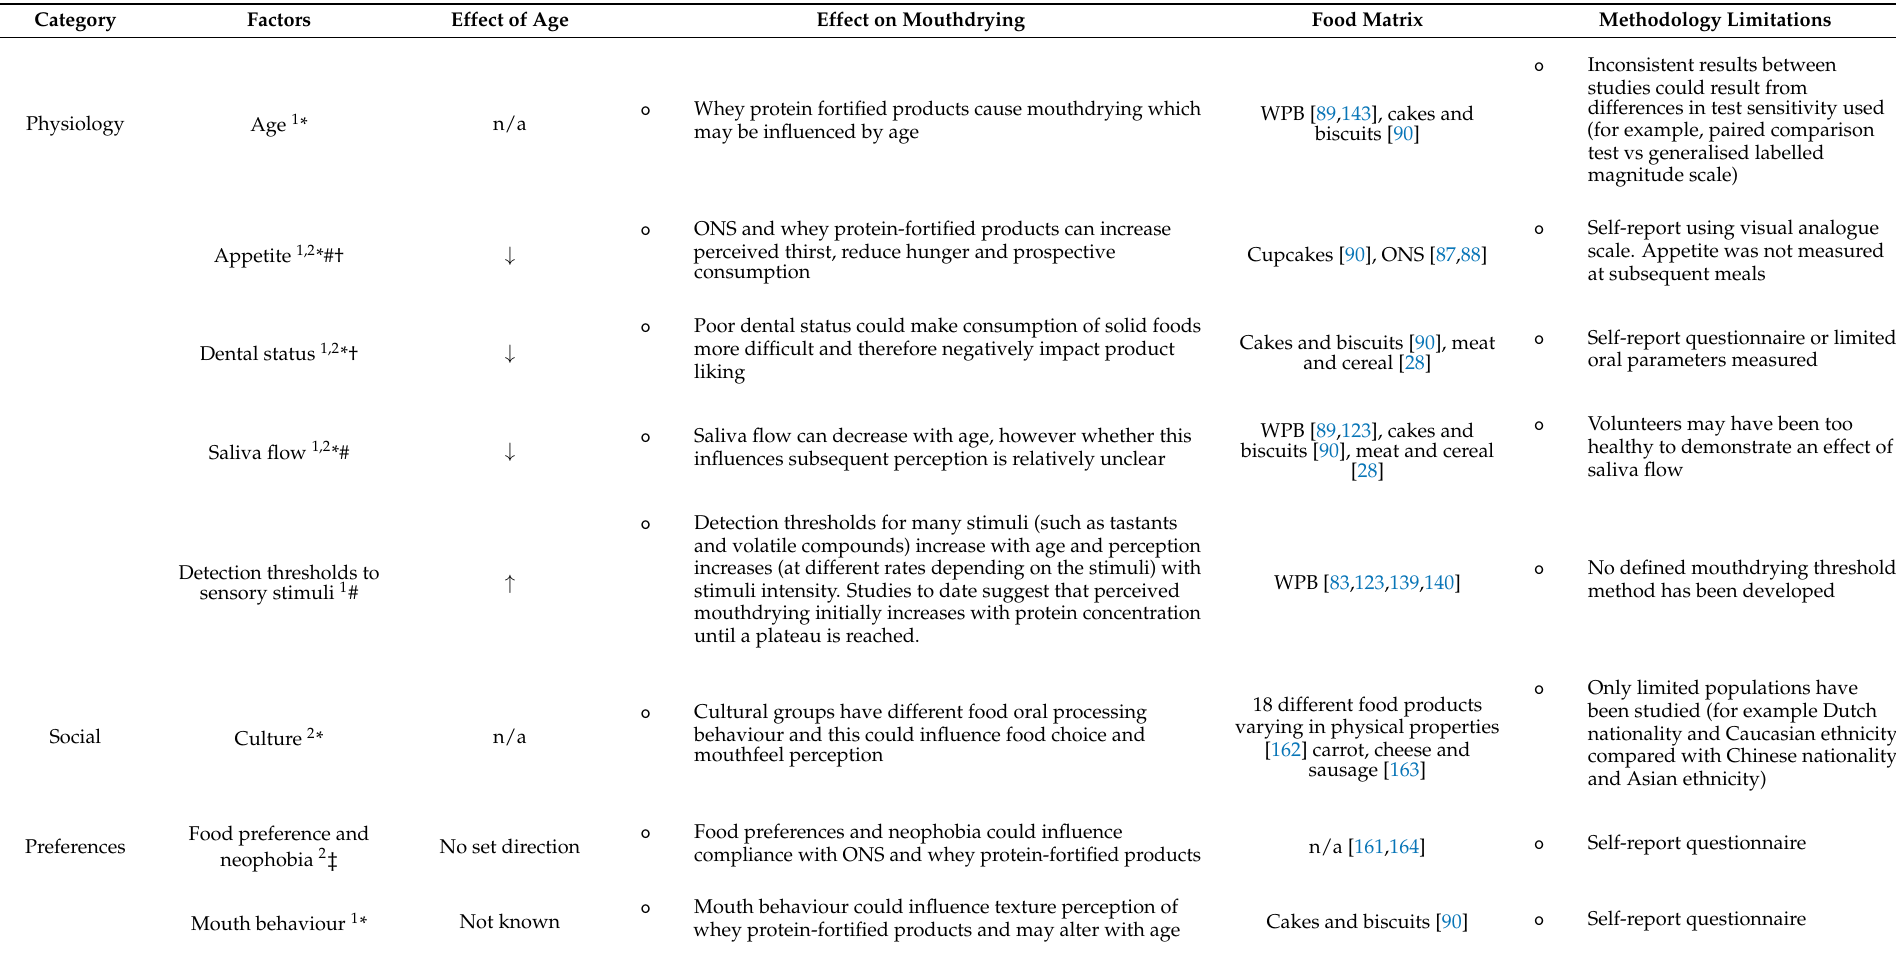
Table 4. Relevant individual differences likely to influence perception of whey protein-derived mouthdrying in older adults ( ↑ increases with age; ↓ decreases with age; n/a not